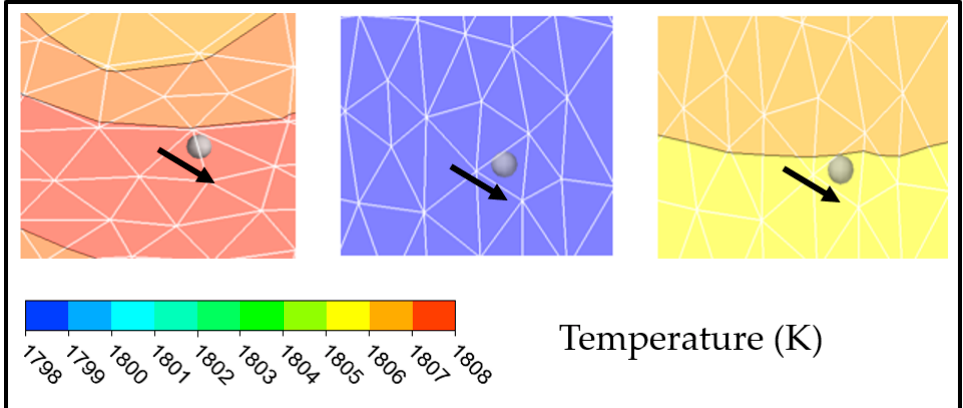
Figure 13. Inclusion motion during solidification due to Marangoni force.